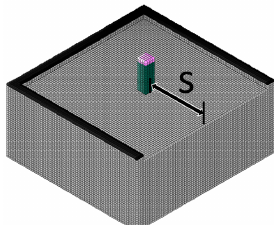
Figure 25. Analysis model with one side free.